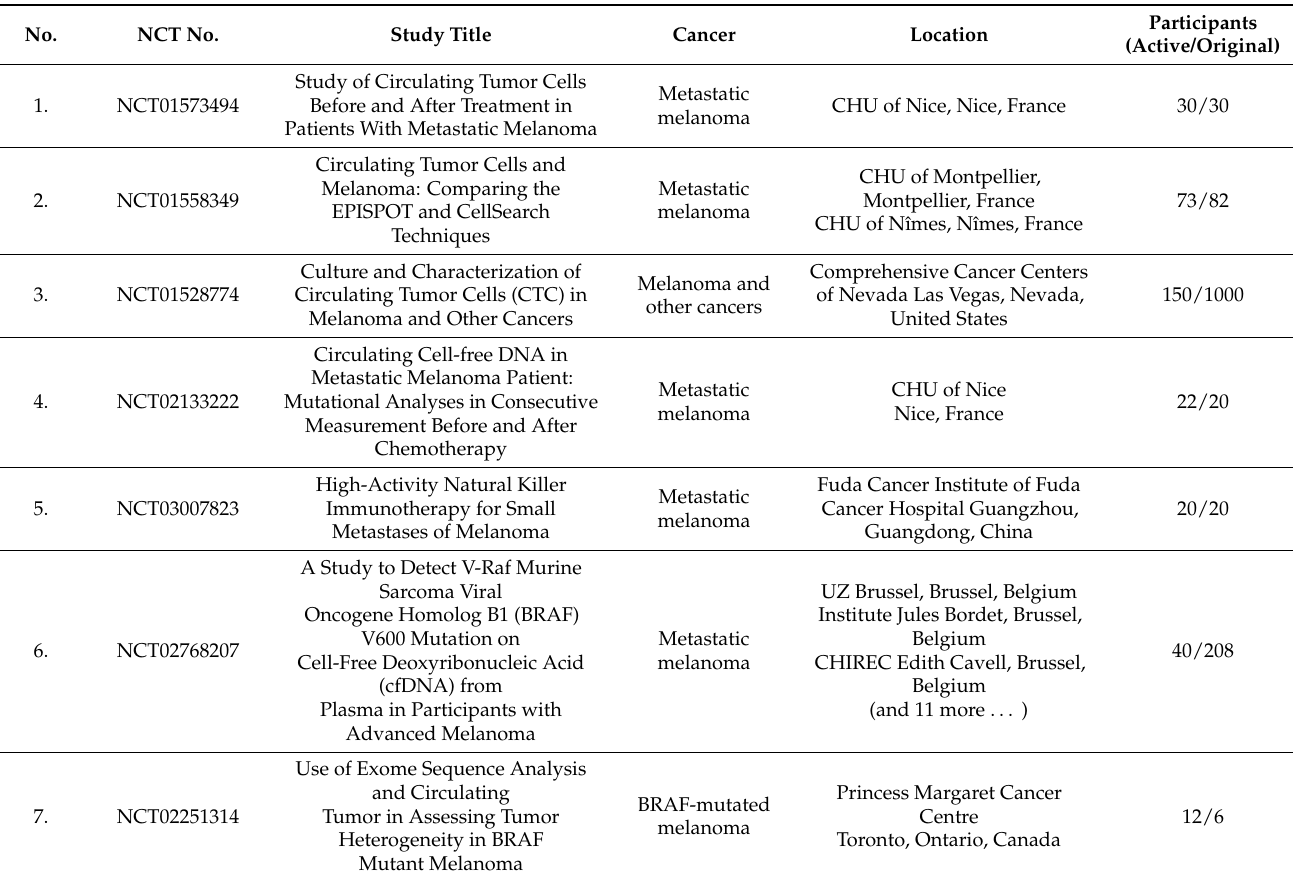
Table 1. Completed clinical studies on circulating melanoma cells and circulating tumor DNA (based on ClinicalTrials.gov (accessed on 7 June